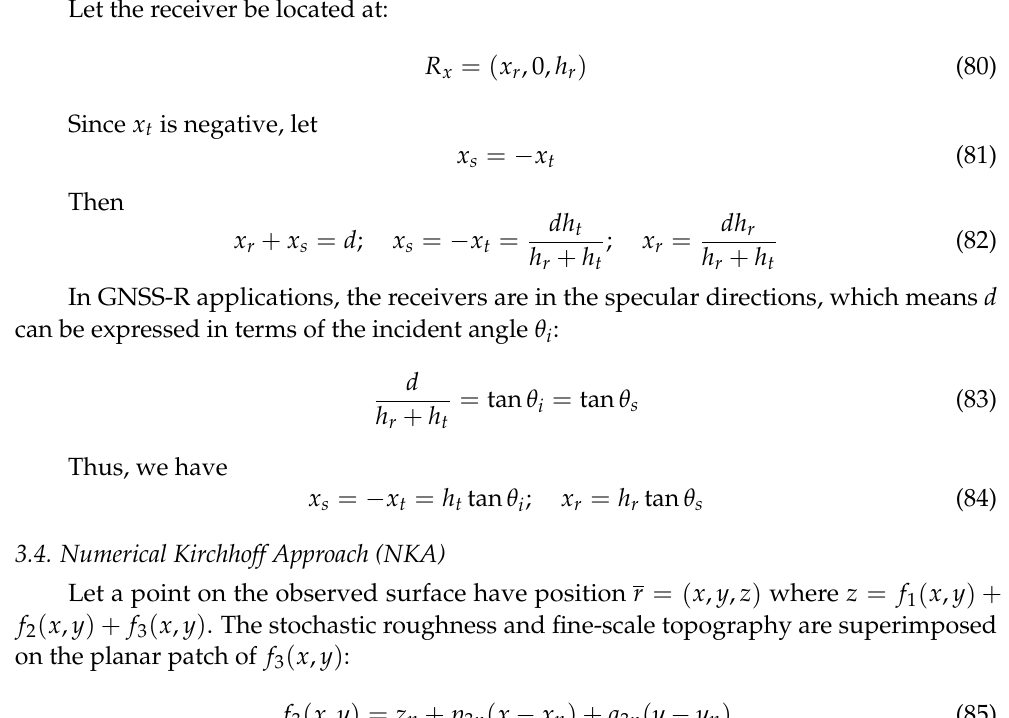
Figure 10 . Specifications of the transmitter and receiver, and definitions of patches and wave vectors.